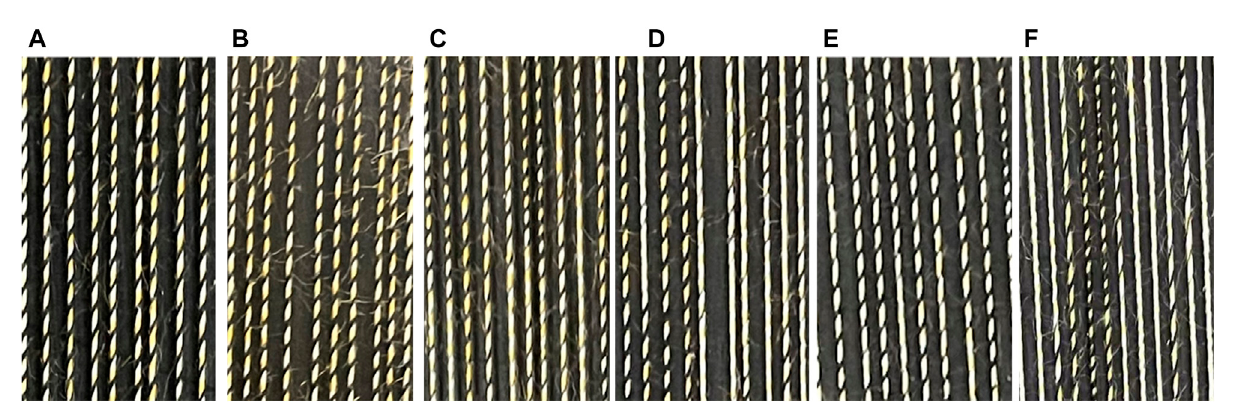
FIGURE 8 Comparisonofevennesspropertiesofthedifferentschemecompoundyarns: (A – F) showtherespectiveuniformityofdifferentcompoundyarnson a black background.